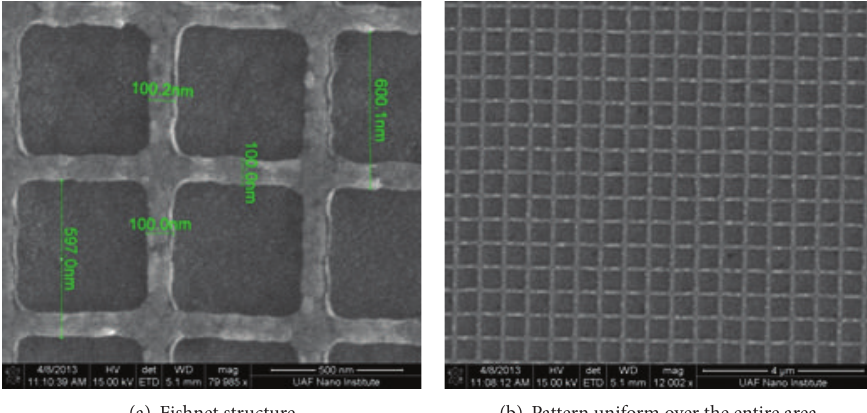
Figure 2: SEM image of the fabricated fishnet structure.